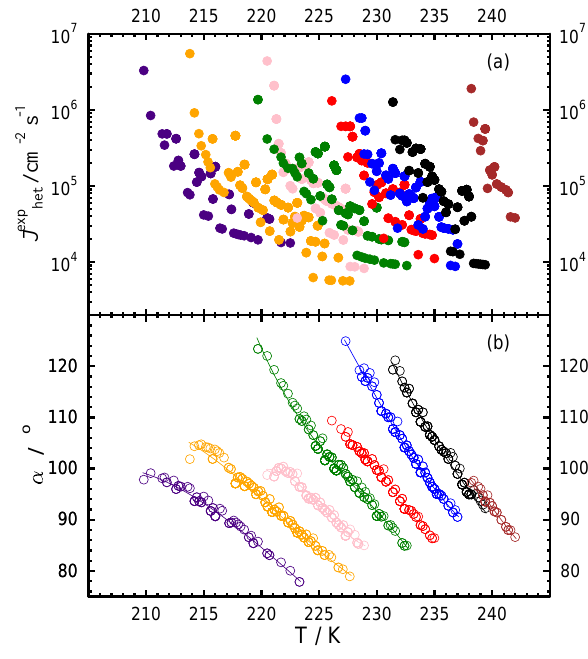
Fig. 2. (a) shows experimentally derived heterogeneous ice nu- , and (b) corresponding contact an- cleation rate coefficients, J exp het gles, α , of leonardite/water and aqueous leonardite/ ( NH 4 ) 2 SO 4 droplets shown as a function of temperature and a w . Brown, black, blue, red, green, pink, orange, and purple circles represent the ini- tial a w of 1.00, 0.971, 0.953, 0.931, 0.913, 0.892, 0.872, and 0.851, respectively. Lines indicate a third-order polynomial